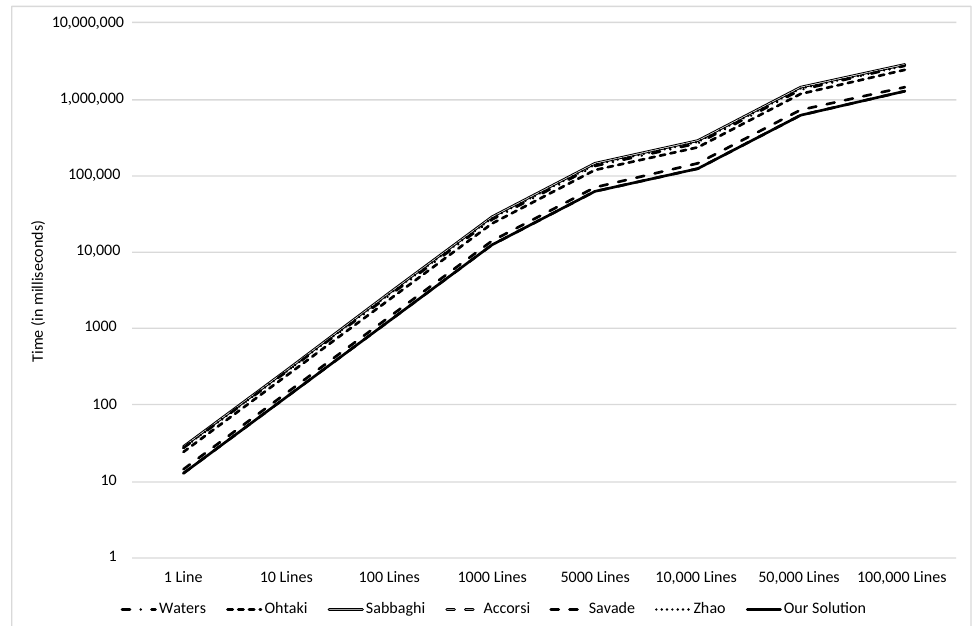
Figure 7. Comparison of indexing times.